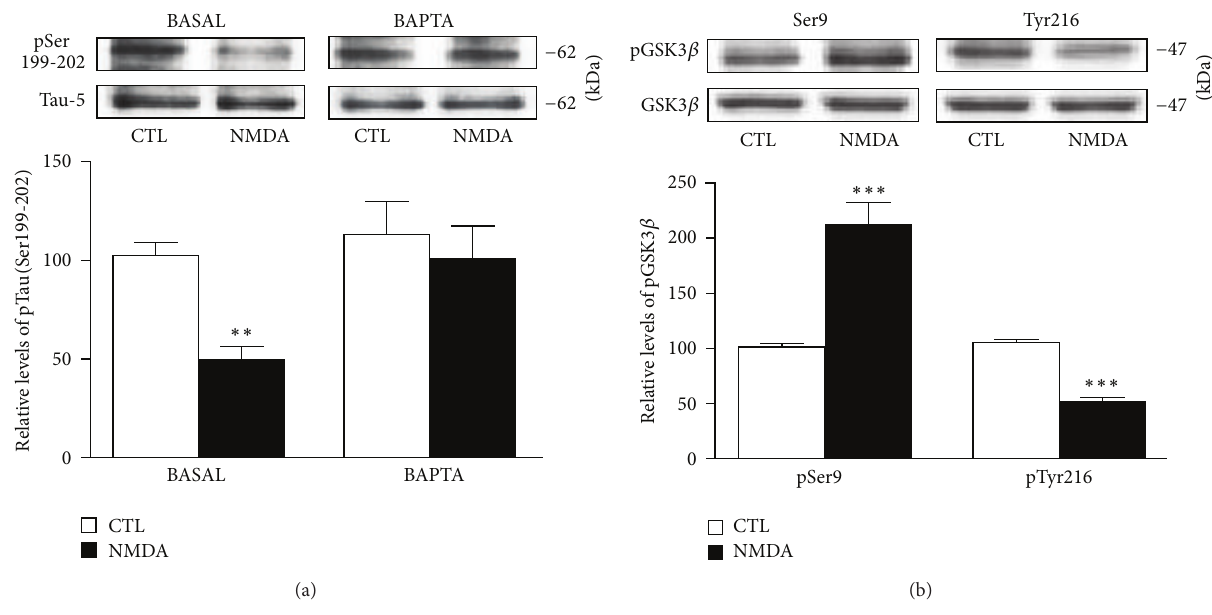
Figure 5: NMDA-induced changes in Tau phosphorylation are mediated by calcium and GSK3 𝛽 . (a) Phosphorylated Tau levels at Ser199- 202 were estimated by Western blotting of cell extracts obtained from hippocampal slices treated with 10 𝜇 M NMDA for 1 hour alone or in combination with 10 𝜇 M BAPTA. The data are expressed relative to total Tau (i.e., Tau-5) levels. (b) Phosphorylated GSK3 𝛽 levels at Ser9 and Tyr216 epitopes were estimated by Western blotting of cell extracts obtained from hippocampal slices treated with 5 𝜇 M NMDA for 1 hour. The data are expressed relative to total GSK3 𝛽 levels as percentages of control values and are means ± S.E.M. of 3 measurements per cell extract obtained from 9 different rats. For statistical analysis, one-way ANOVA was followed by Newman-Keuls post hoc test. ∗∗ 𝑃 < 0.01 , ∗∗∗ 𝑃 < 0.001 , drug-treated versus control.